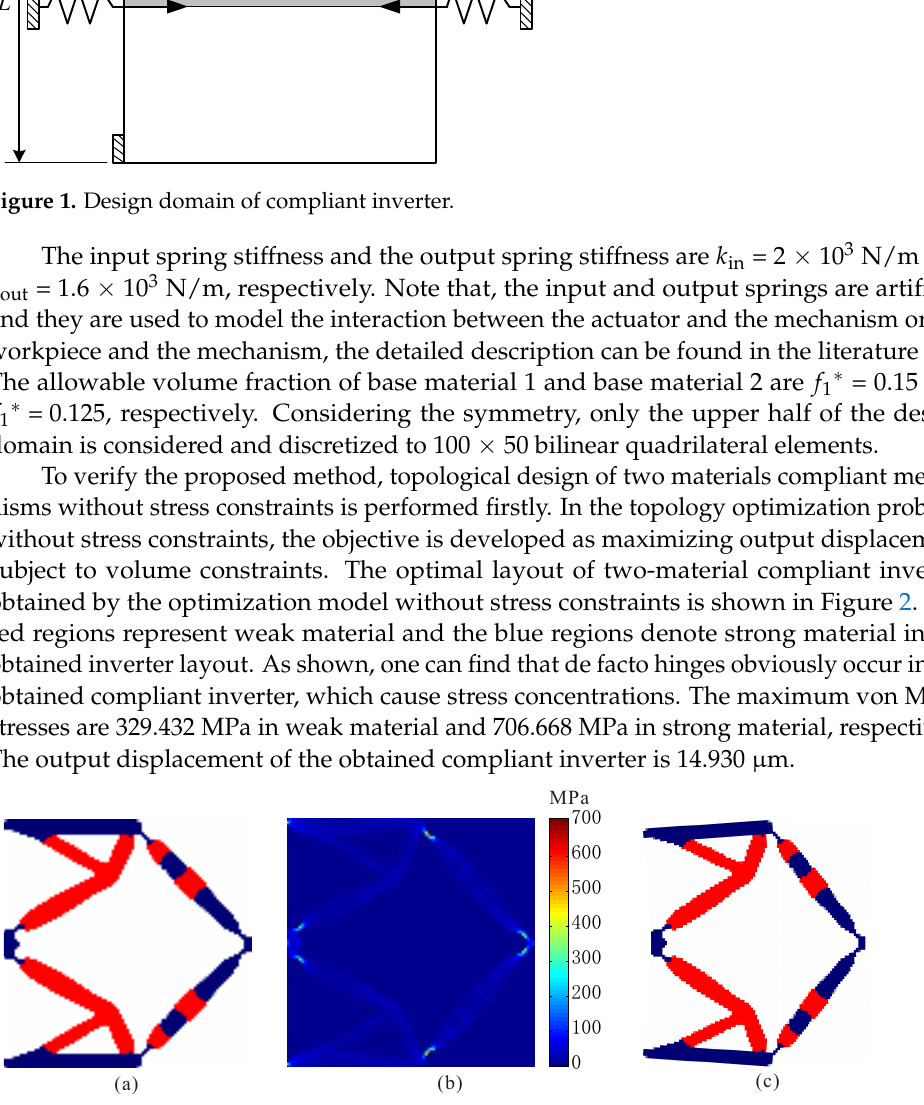
(c) Figure 3. The results for topological design of multi-material compliant inverter with stress constraints ( * 1 σ = 275 MPa,